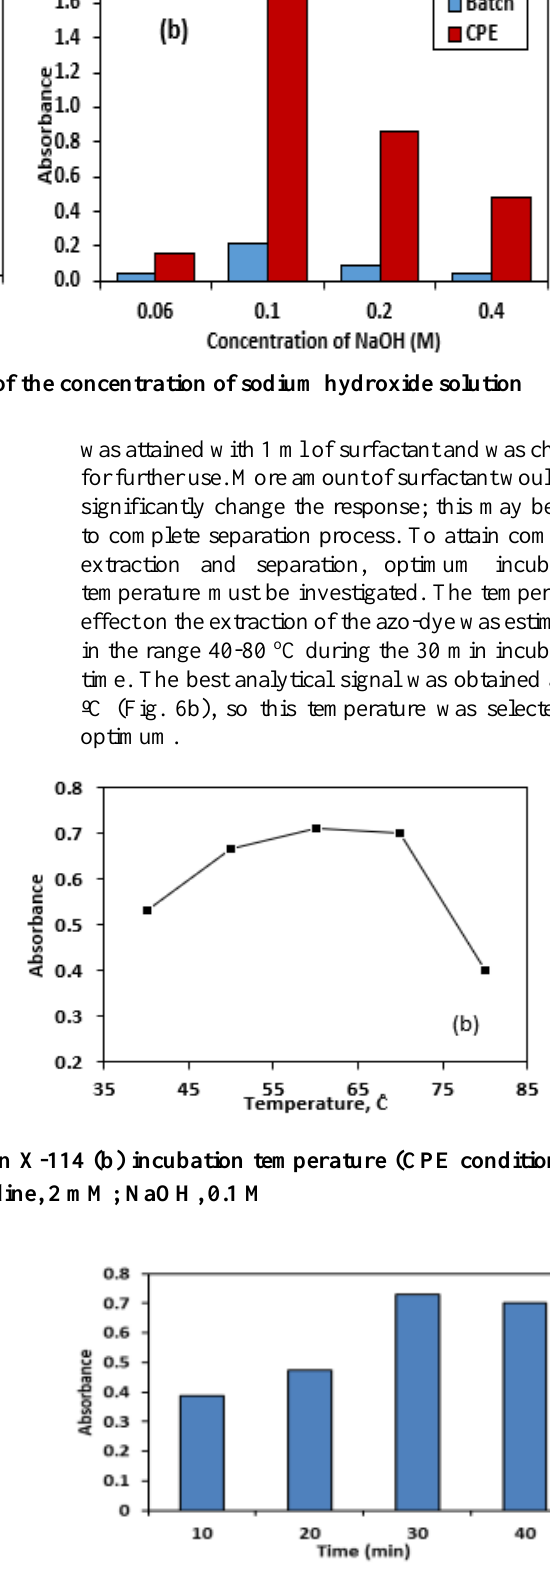
Figure. 7. Study of the incubation time (CPE conditions: 4 µg/ml of ISX; sulfadimidine, 2 mM; NaOH, 0.1 M; Triton X-114, 1% (v/v); Temp.,